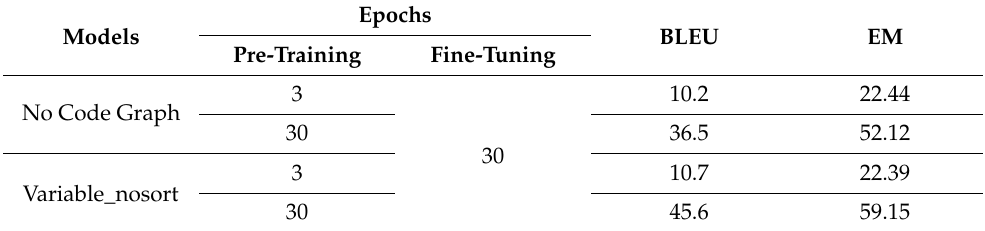
Table 11. Comparison results of the pre-trained model from scratch with and without code